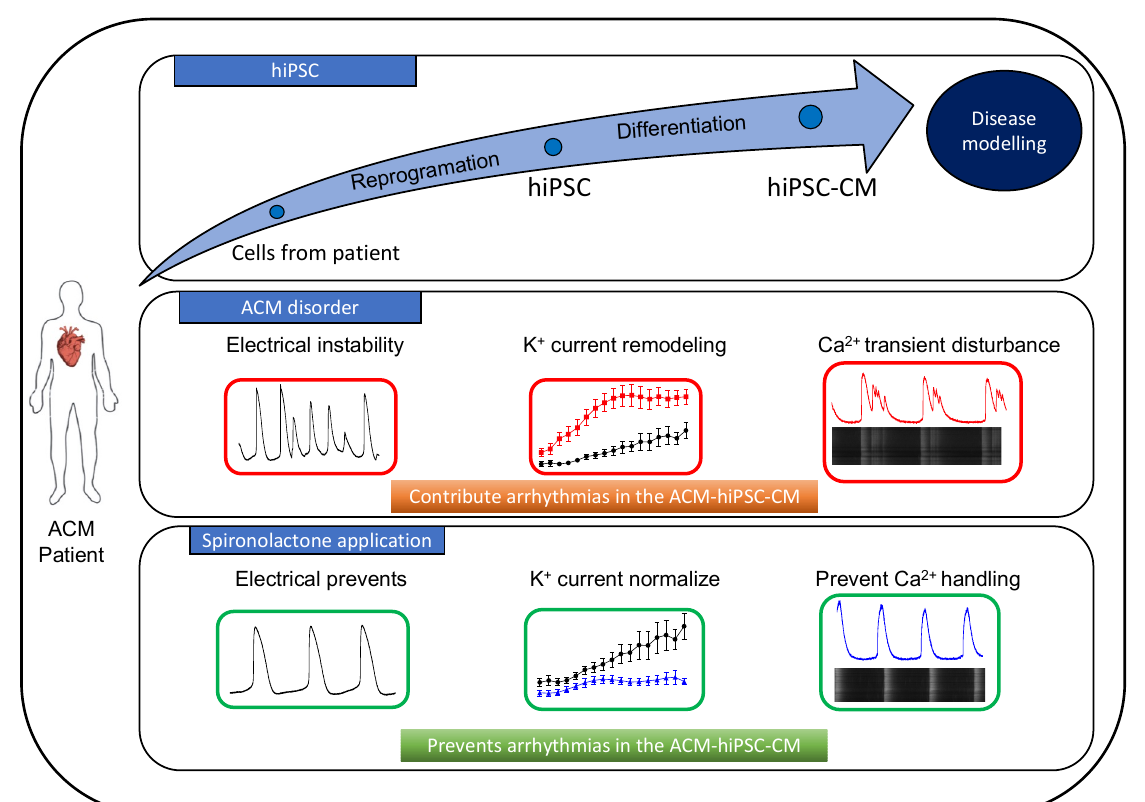
Figure 7. Schematic diagram of a benefits effects of Spironolactone on ACM-hiPSC-CM. HiPSC-CMs harboring a desmosomal mutation allow one to decipher the ACM disease. The electrophysiological and calcium-handling properties disturbed in this pathology. Application of Spironolactone prevents these effects, by a normalization of Action potential duration, electrical stability and a calcium handling restored. Spironolactone can reduce the risk of ventricular arrhythmias in ACM patients.